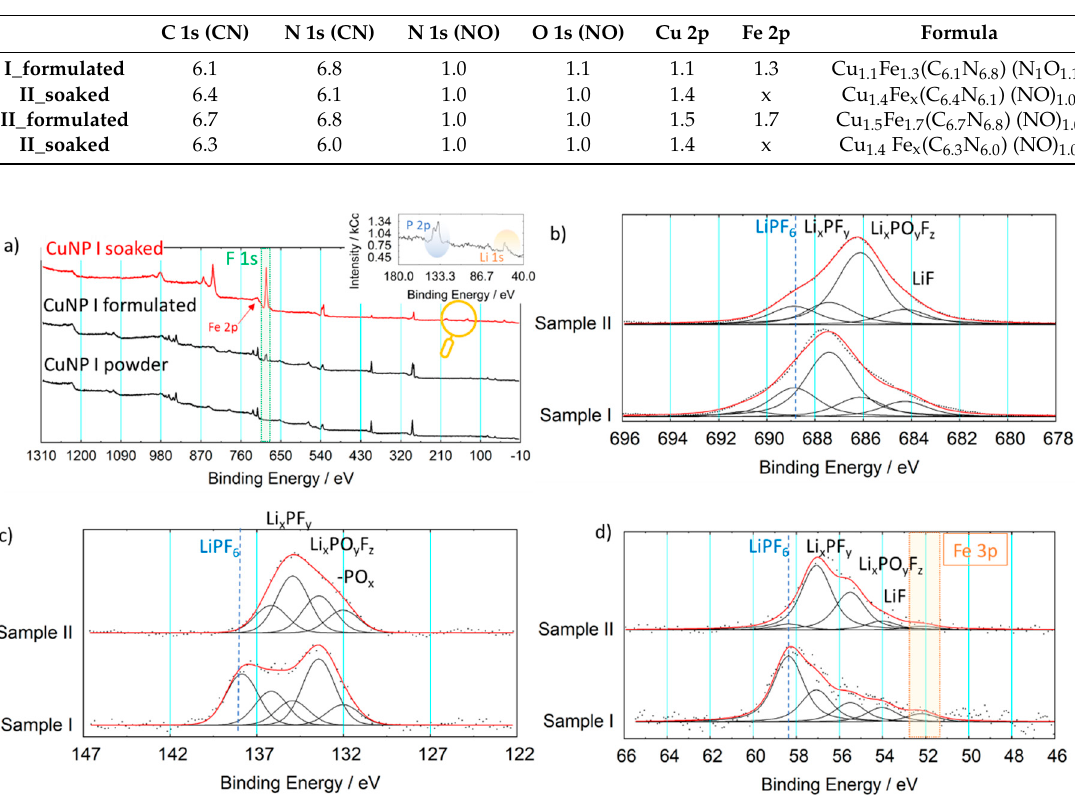
Table 3. XPS quantification (normalized areas) of sample I and II formulated and soaked into the electrolyte. For soaked samples, the value of N (NO) was set to 1.